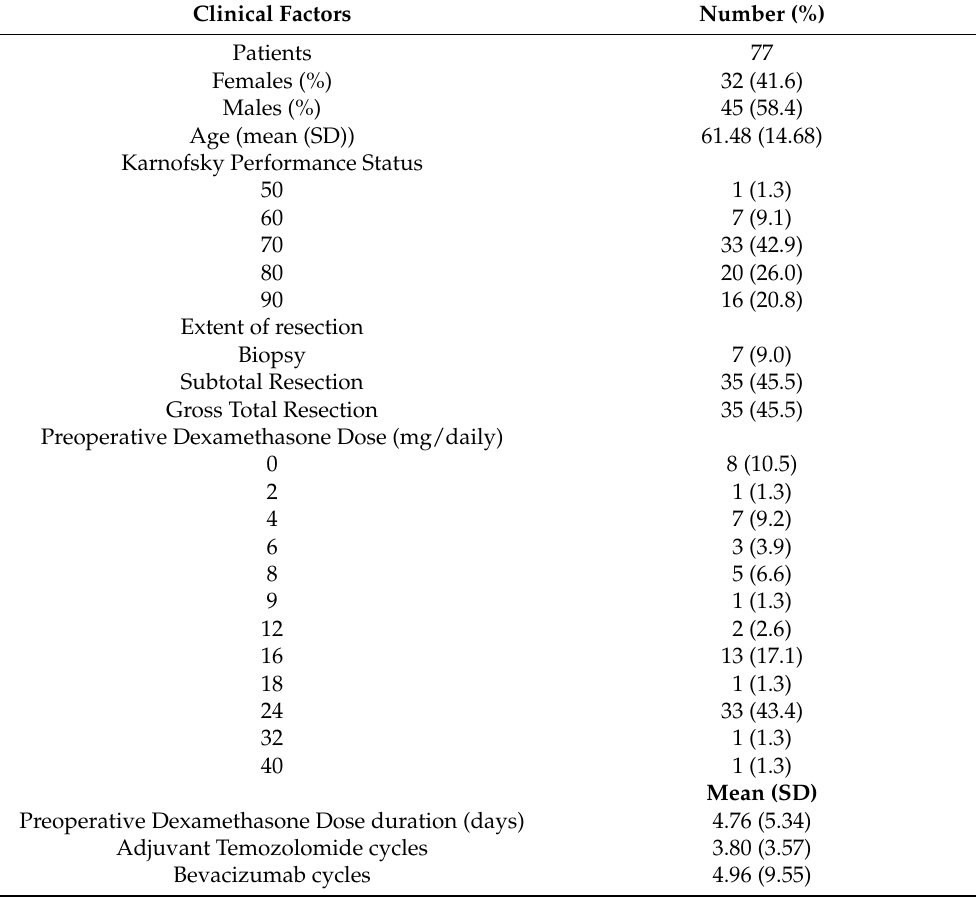
Table 1. Summary of Clinical